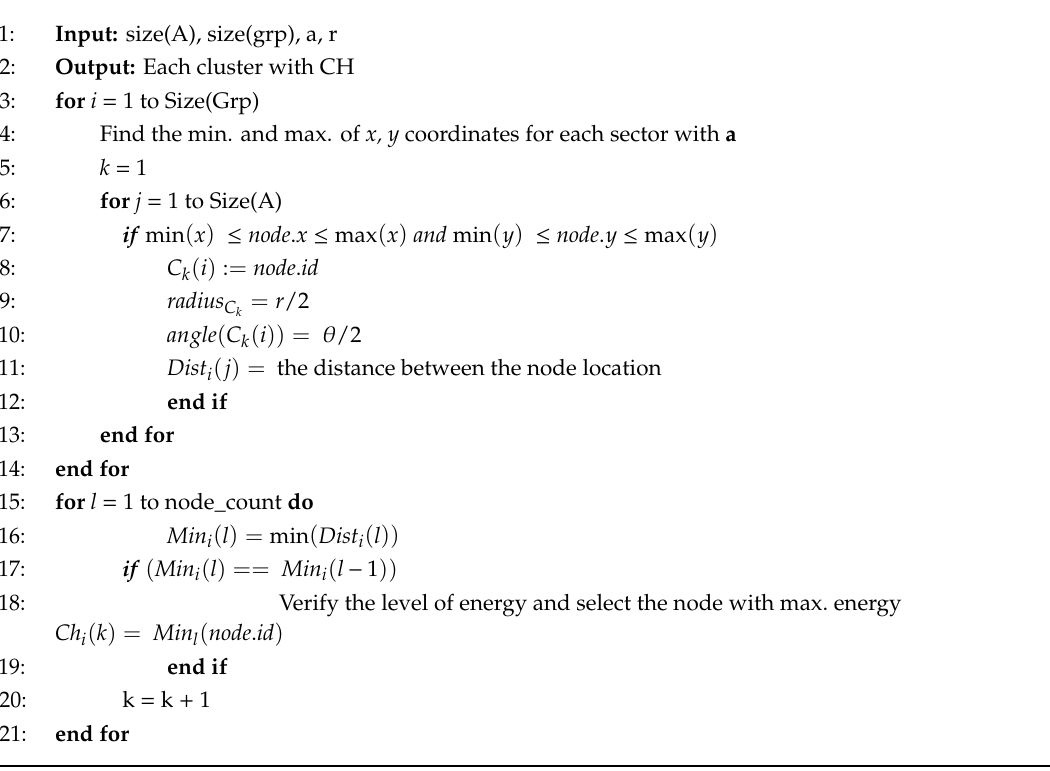
Algorithm 2. CH selection in radial-shaped